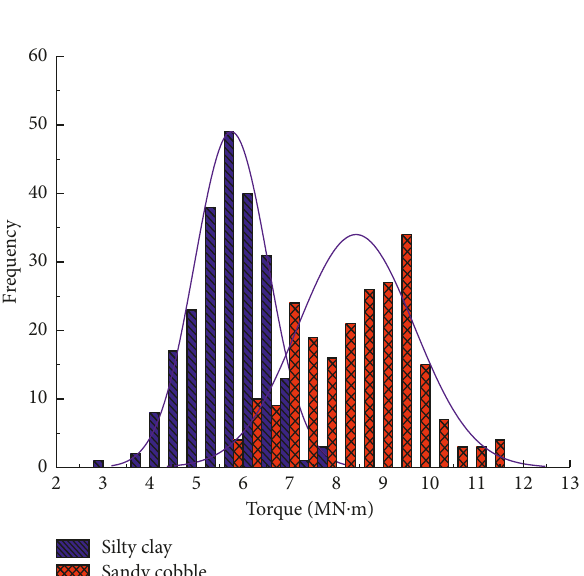
Figure 6: History of cutterhead torque.